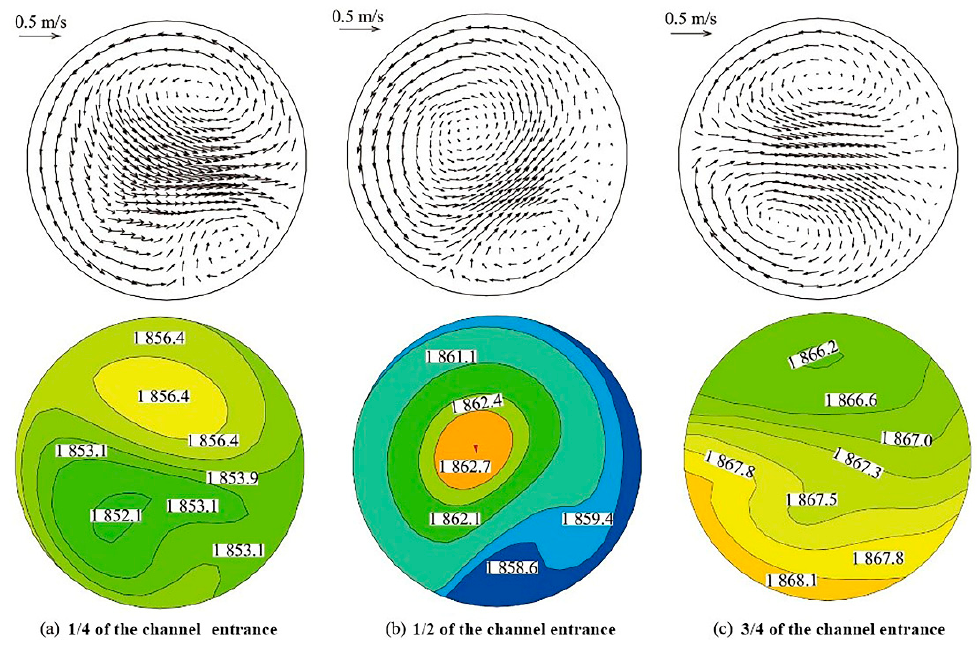
Figure 4. Molten steel flow and heat transfer at the different positions of the IHT channel [37] .